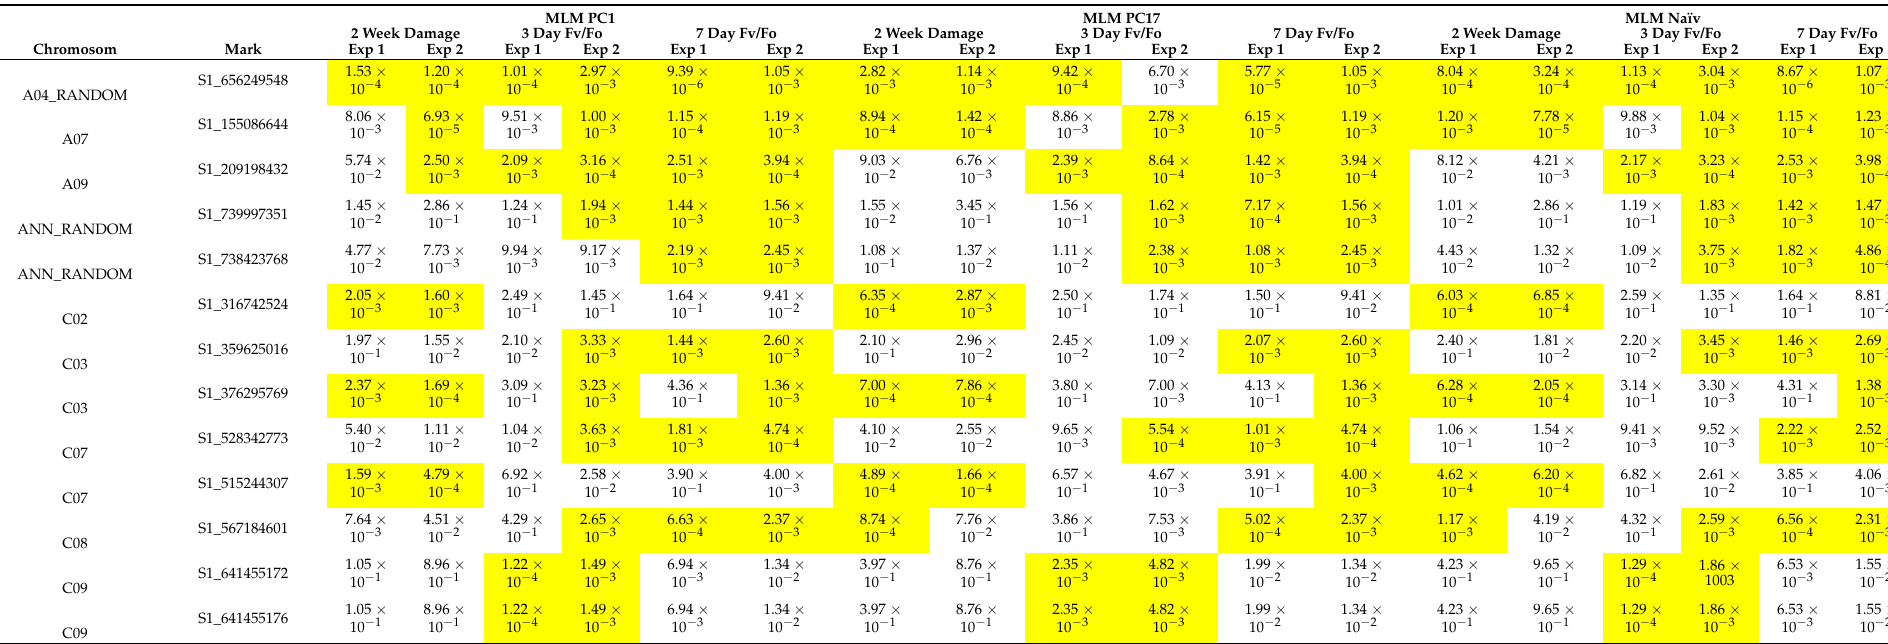
Table 3. p -Value of SNP–phenotype associations based on mixed linear model. Thirteen significant loci were identified among both experimental runs for any one of the phenotypes